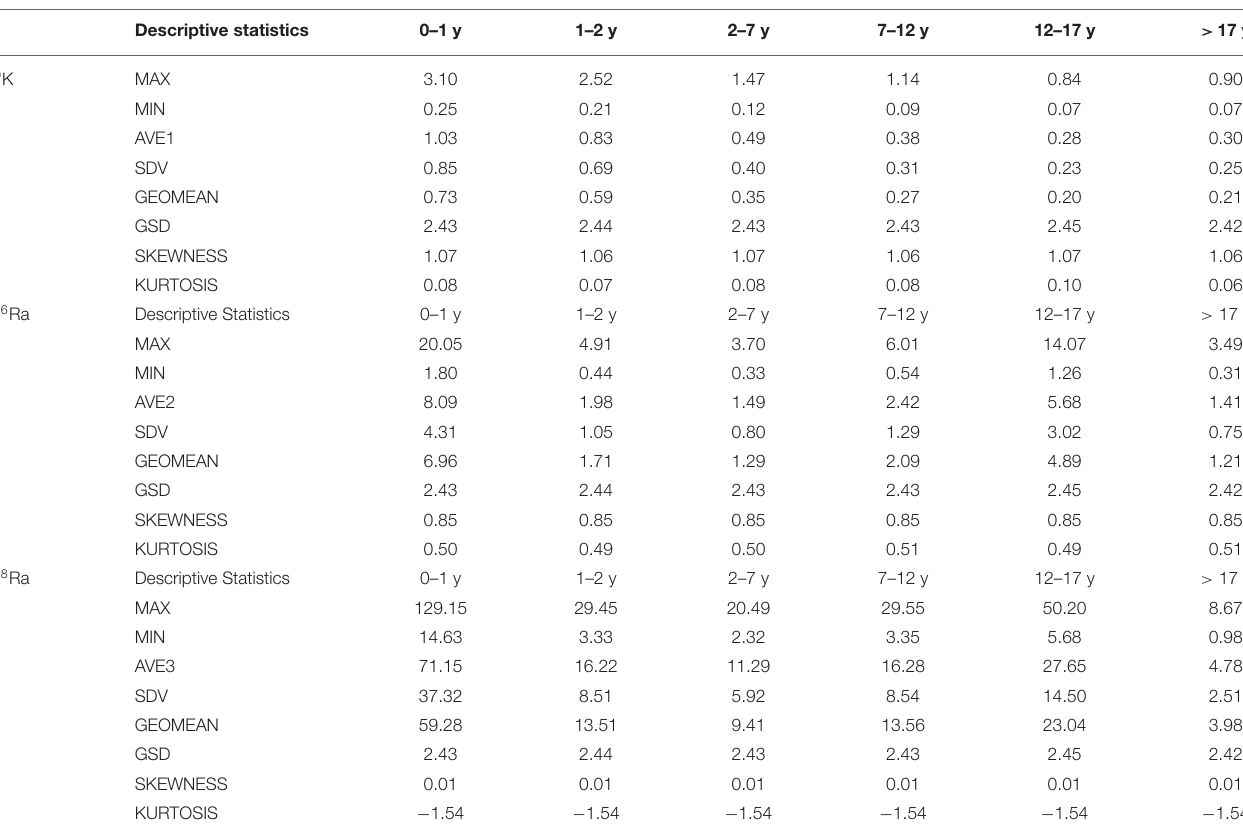
TABLE 3 | Age–dependent annual effective dose (mSv/y) for the radionuclides. Descriptive